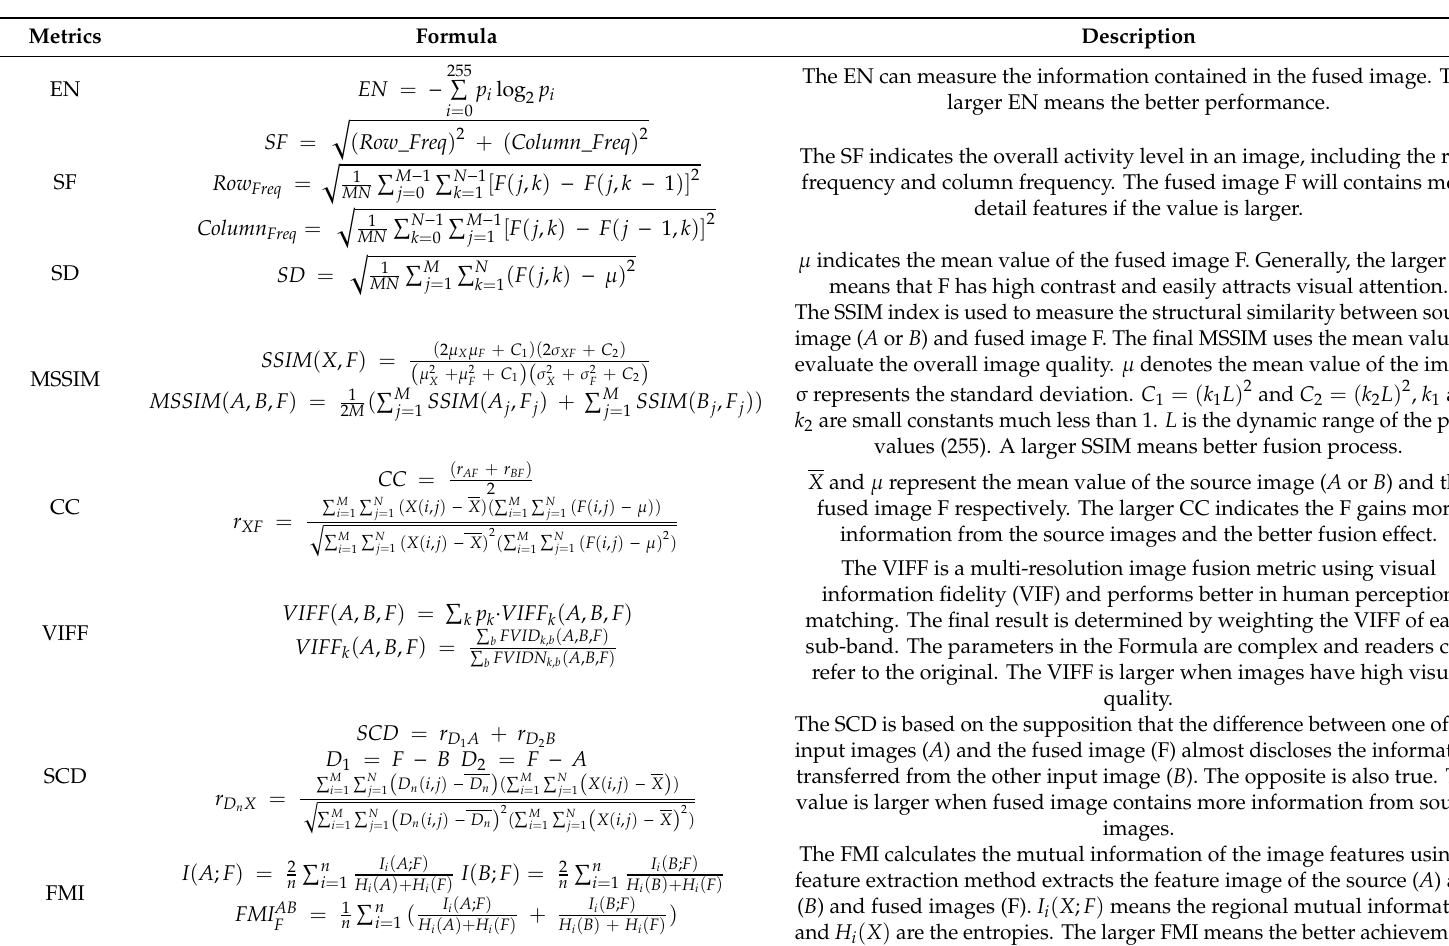
Table 3. The metrics for fusion